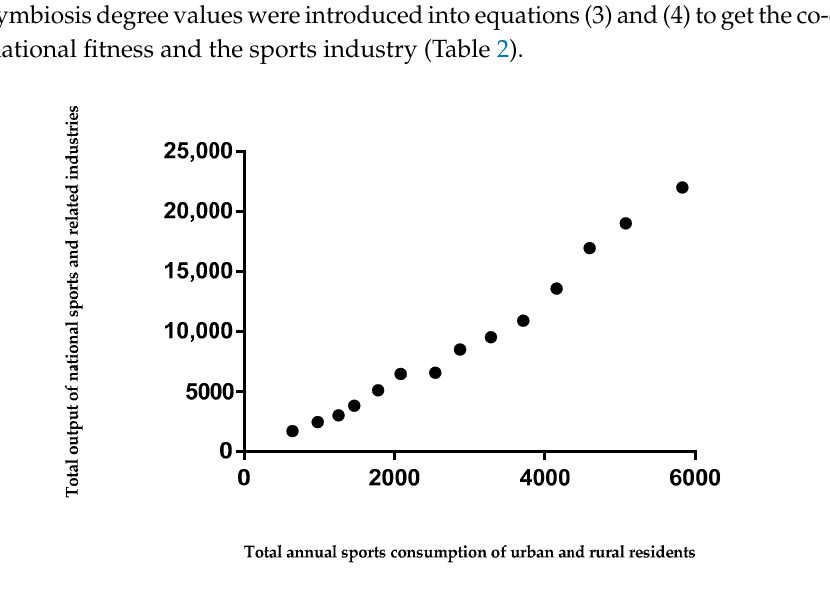
Figure 2. Scatter plot of the primary quality parameters. Table 2. Symbiosis degree and model of national fitness (NF) and the sports industry